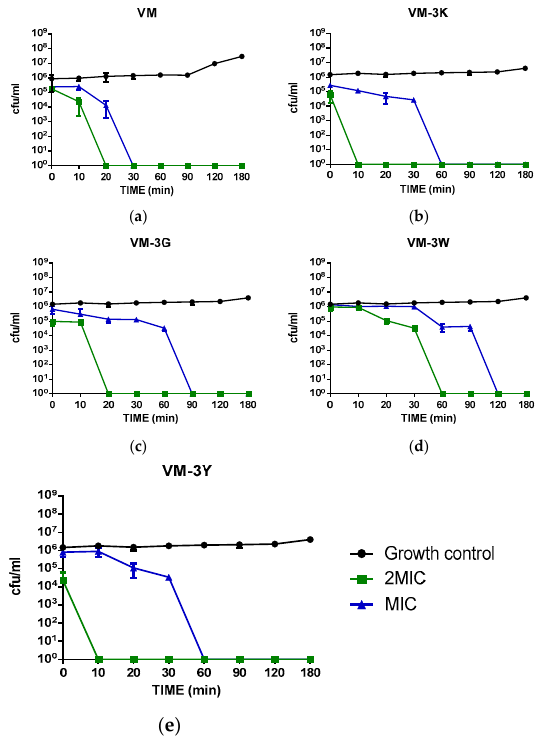
Figure 2. Bacterial killing kinetics of five VM peptides that have potent antibacterial ability against S. aureus . ( a ) The bacterial killing kinetics of VM; ( b ) The bacterial killing kinetics of VM-3K; ( c ) The bacterial killing kinetics of VM-3G; ( d ) The bacterial killing kinetics of VM-3W; ( e ) The bacterial killing kinetics of VM-3Y. The bacteria were treated with peptides for 180 min at concentrations corresponding to 1× MIC and 2× MIC. The bacteria treated with broth only were used as growth controls. Data points represent mean ± standard error of means (SEM) of nine replicates from three independent experiments.